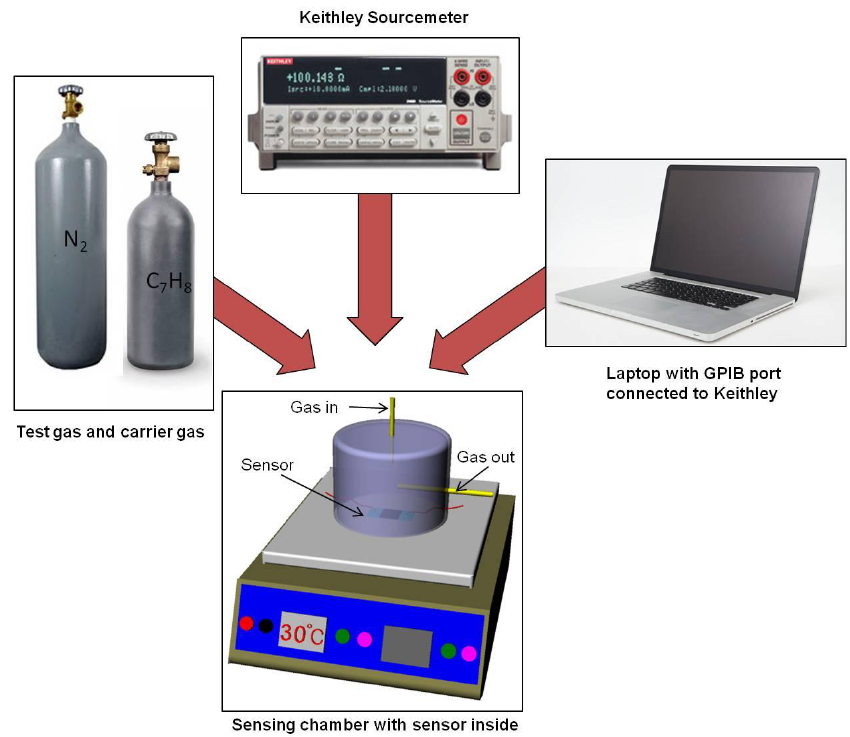
Figure 2. Schematic representation of the sensor testing